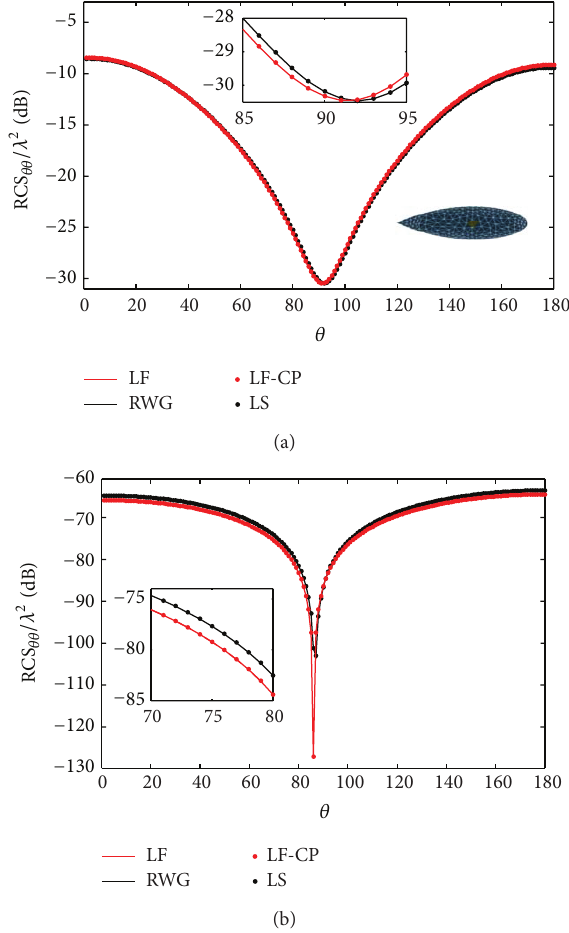
Figure 8: BiRCSs of the PEC cube @ 0.5 GHz.